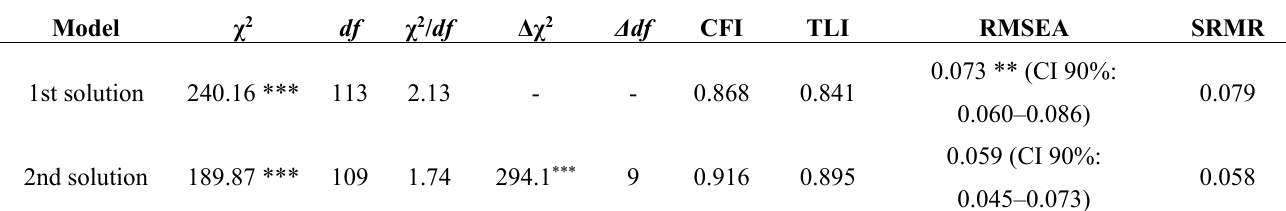
Table 4. Fit indices for first and second solution of Confirmatory Factor Analysis (CFA).